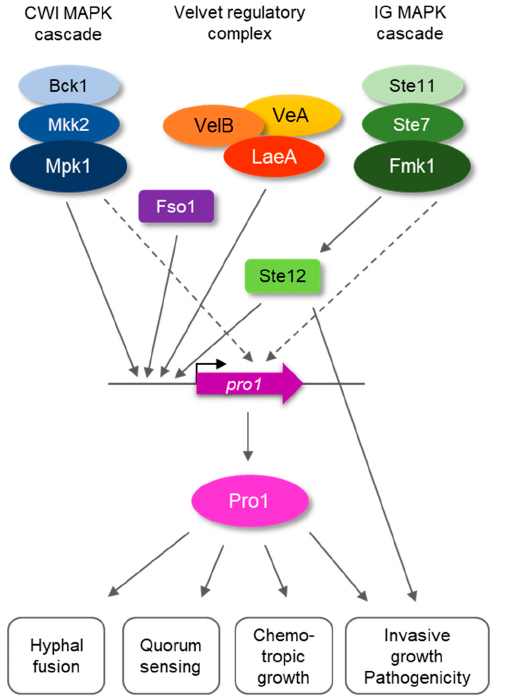
Figure 6. Diagram showing regulation of Pro1 by different upstream components in F. oxysporum .